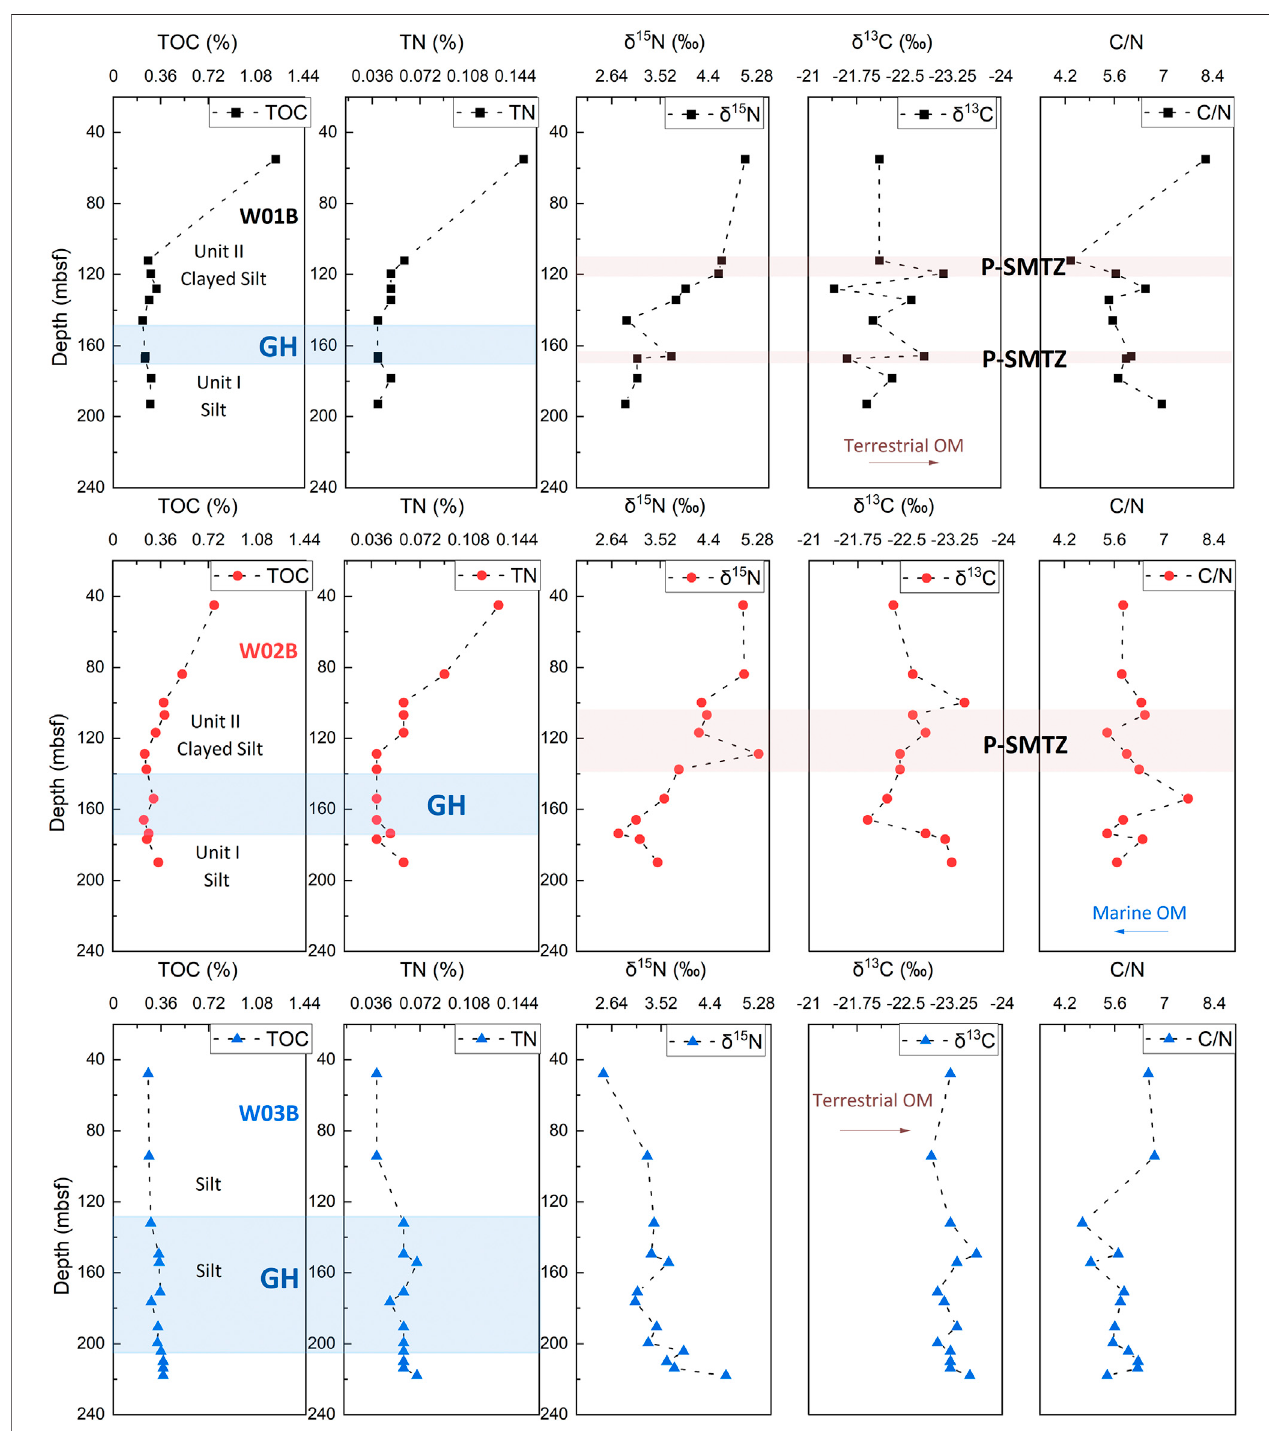
FIGURE 2 | Depth pro fi les of TOC, TN, δ 15 N, δ 13 C org , and C/N ratio for W01B, W02B, and W03B from the Shenhu area, SCS. The blue shaded areas indicate the hydrate-bearing layer, and the pink shaded areas imply the possible paleo-sulfate methane transition zone (SMTZ).